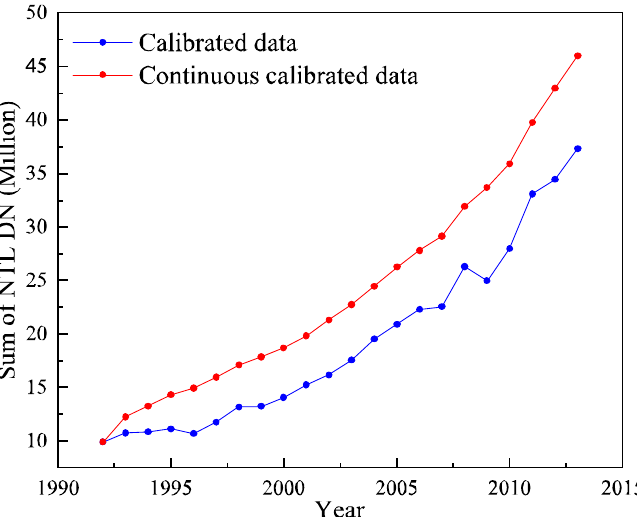
where n = 1992, 1993, ..., 2011, 2012; DN n is the total DN value of lit pixels in the previous year; and DN n +1 is the total DN value of lit pixels in the following year. The Chinese regional DMSP-OLS satellite long time series nighttime light reconstruction dataset based on the ISC method was obtained, as shown in Figure 8.